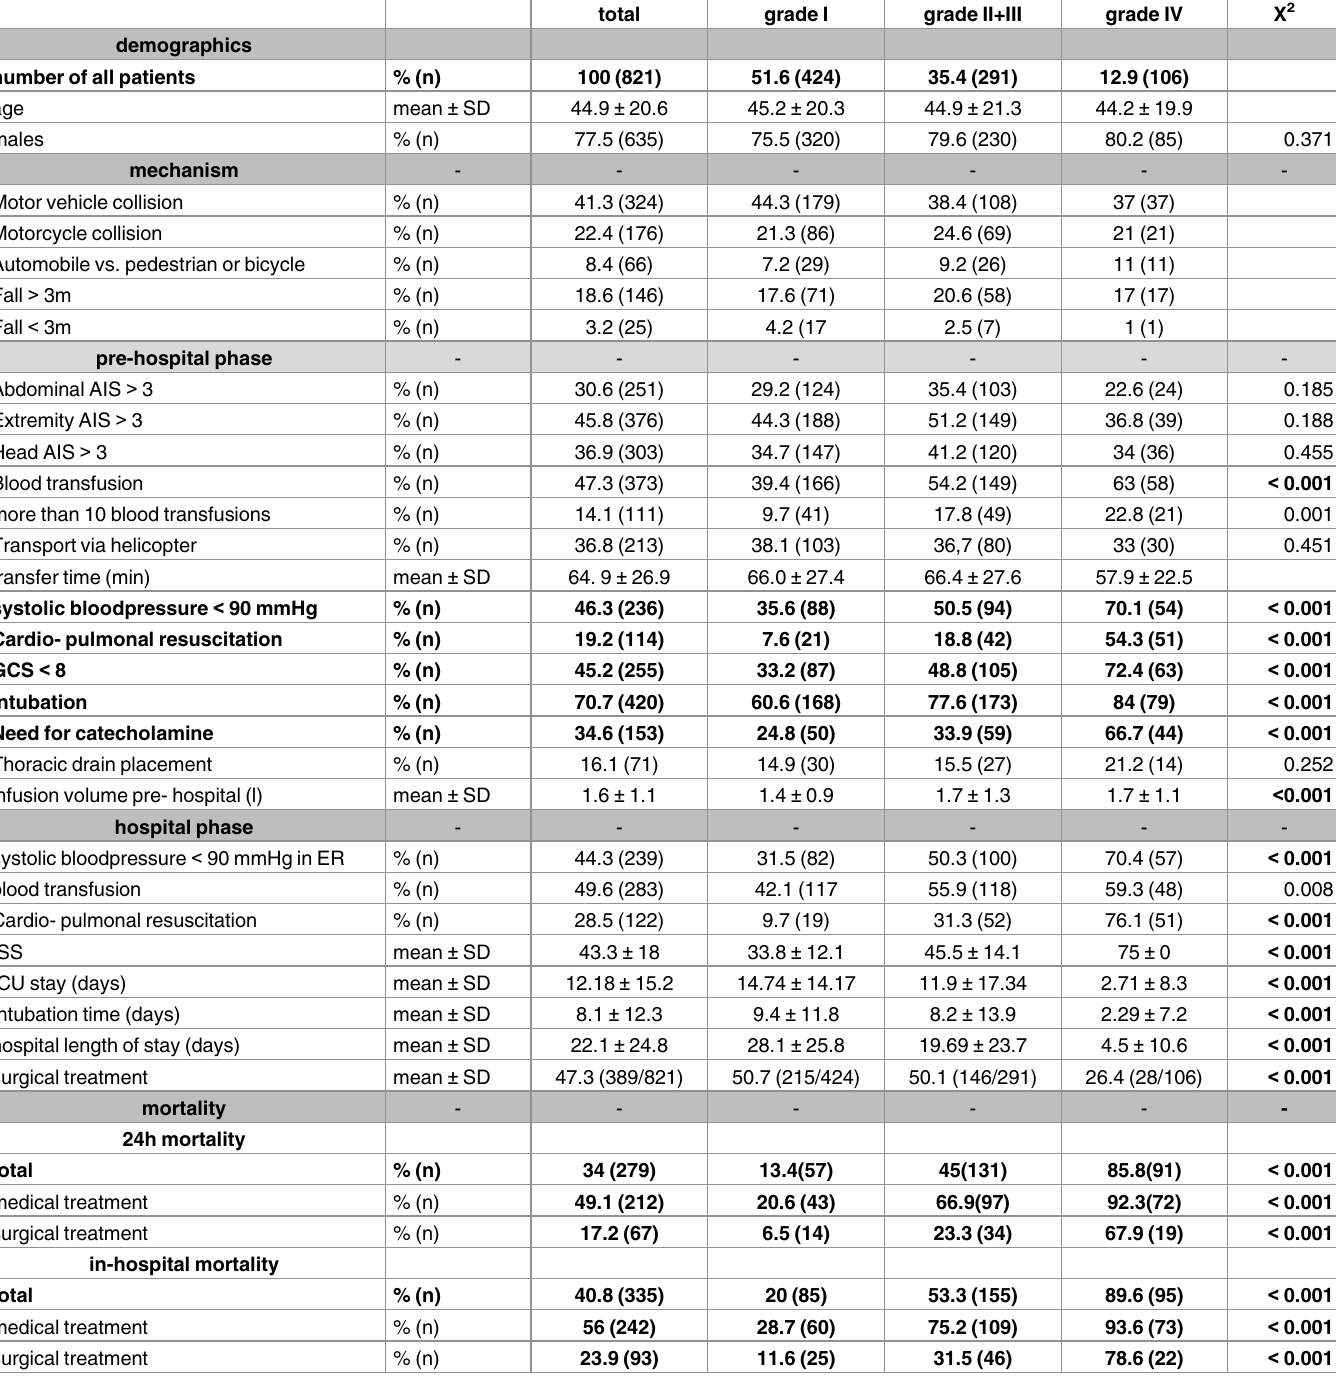
Table 1. Data of the pre- hospital and hospital phase and the mortality rate, separated by the three different groups of